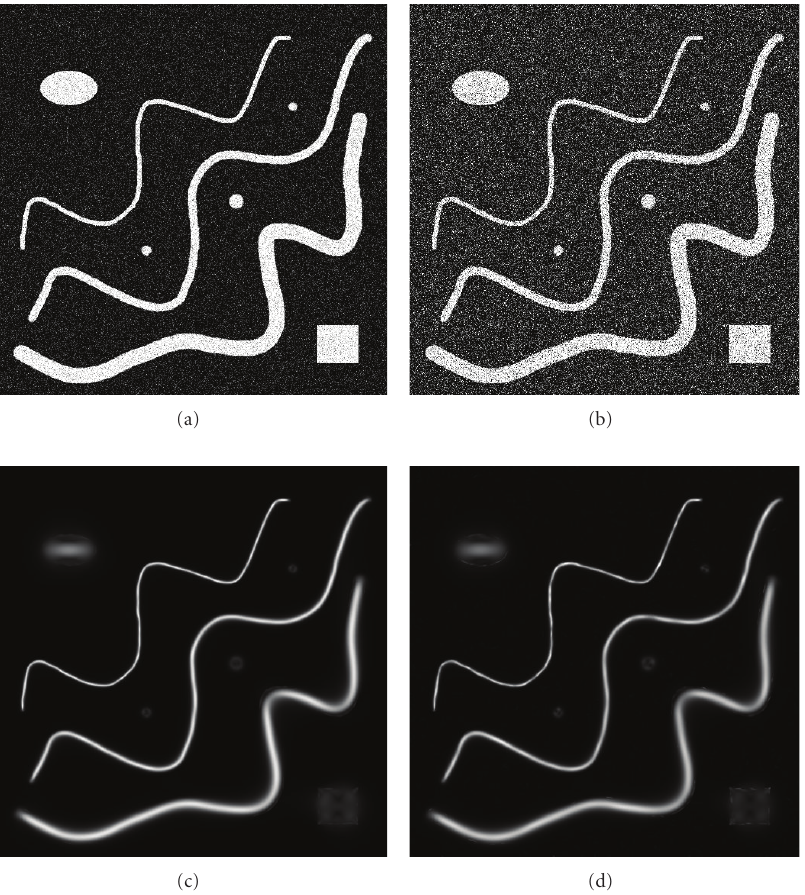
Figure 8: Automatic processing. Input images with noise mean = 0 and standard deviation (a) SD = 25 and (b) SD = 50; processed images (c) and